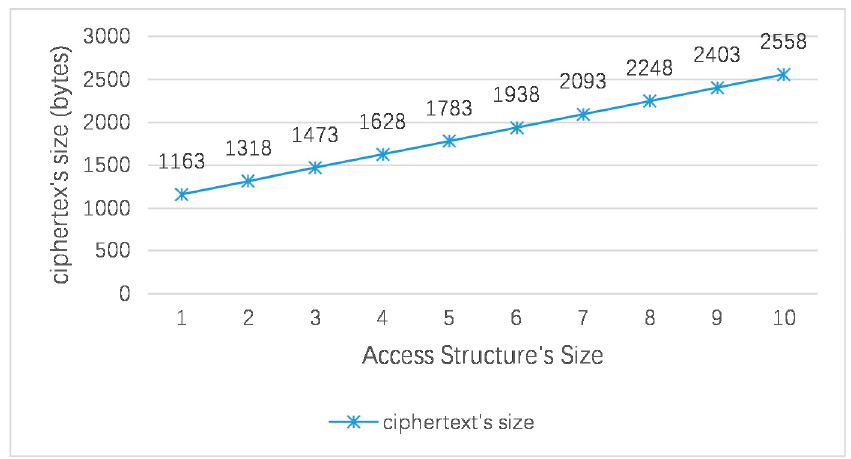
Figure 12. Hybrid ABE’s ciphertext’s size with respect to the access structure’s size (1 KB plaintext).